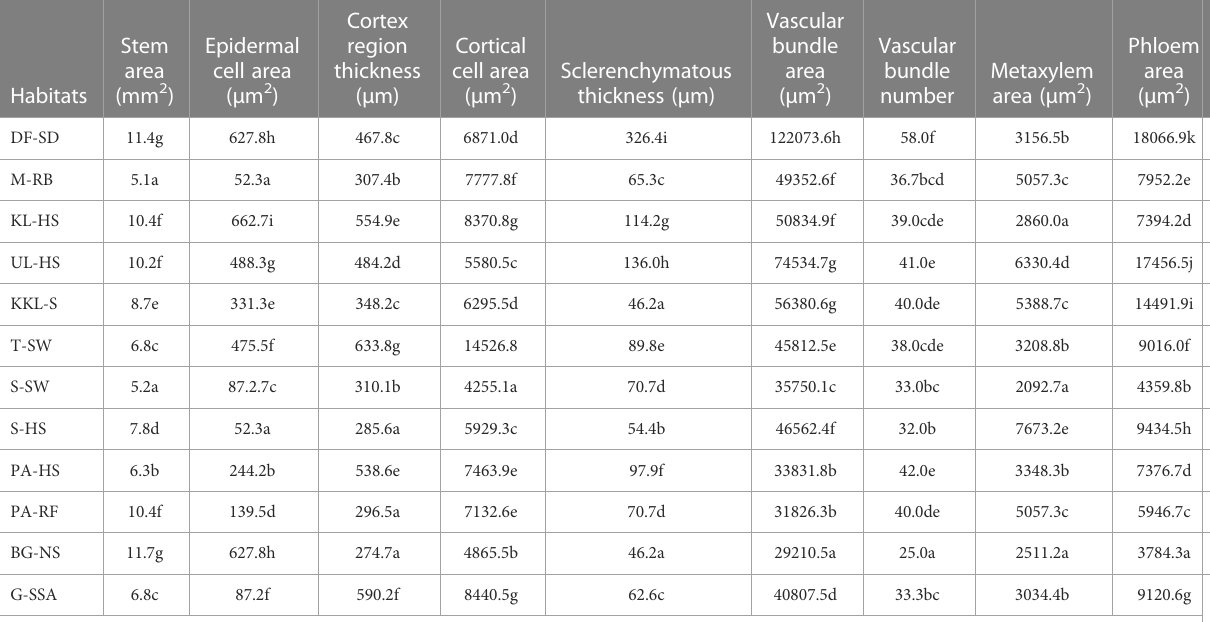
TABLE 3 Stem anatomical characteristics of the selected habitats from Punjab,